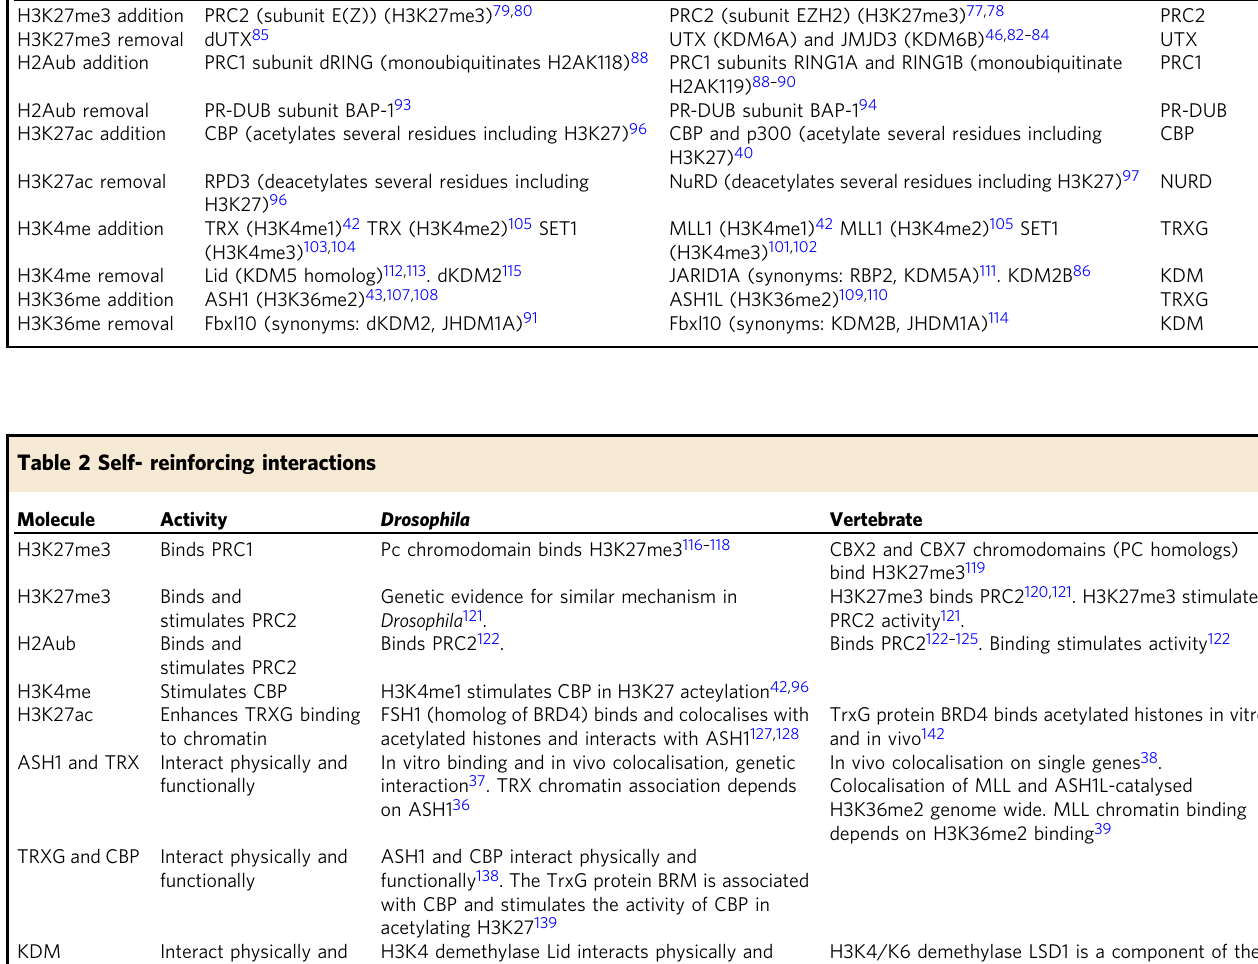
Table 1 Enzymes and histone modi fi cations represented in the model Activity Enzyme or complex ( Drosophila ) Enzyme or complex